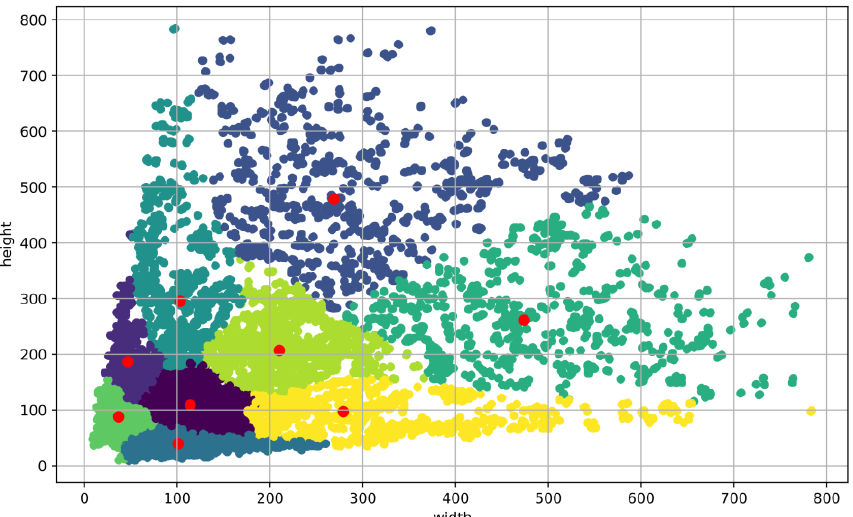
Figure 7. Examples of cargo ships in remote sensing images. ( a ) bulk carrier; ( b ) container; ( c ) tanker.